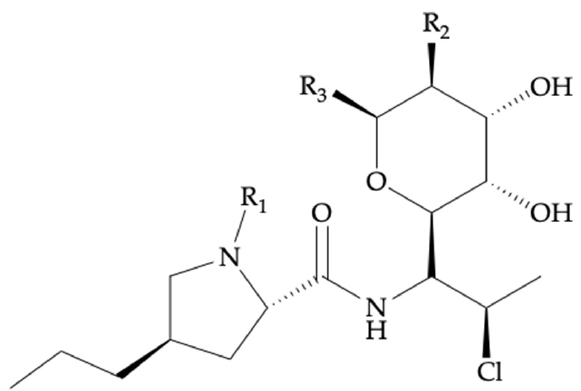
Figure 2. Chemical structure for clindamycin and related components.